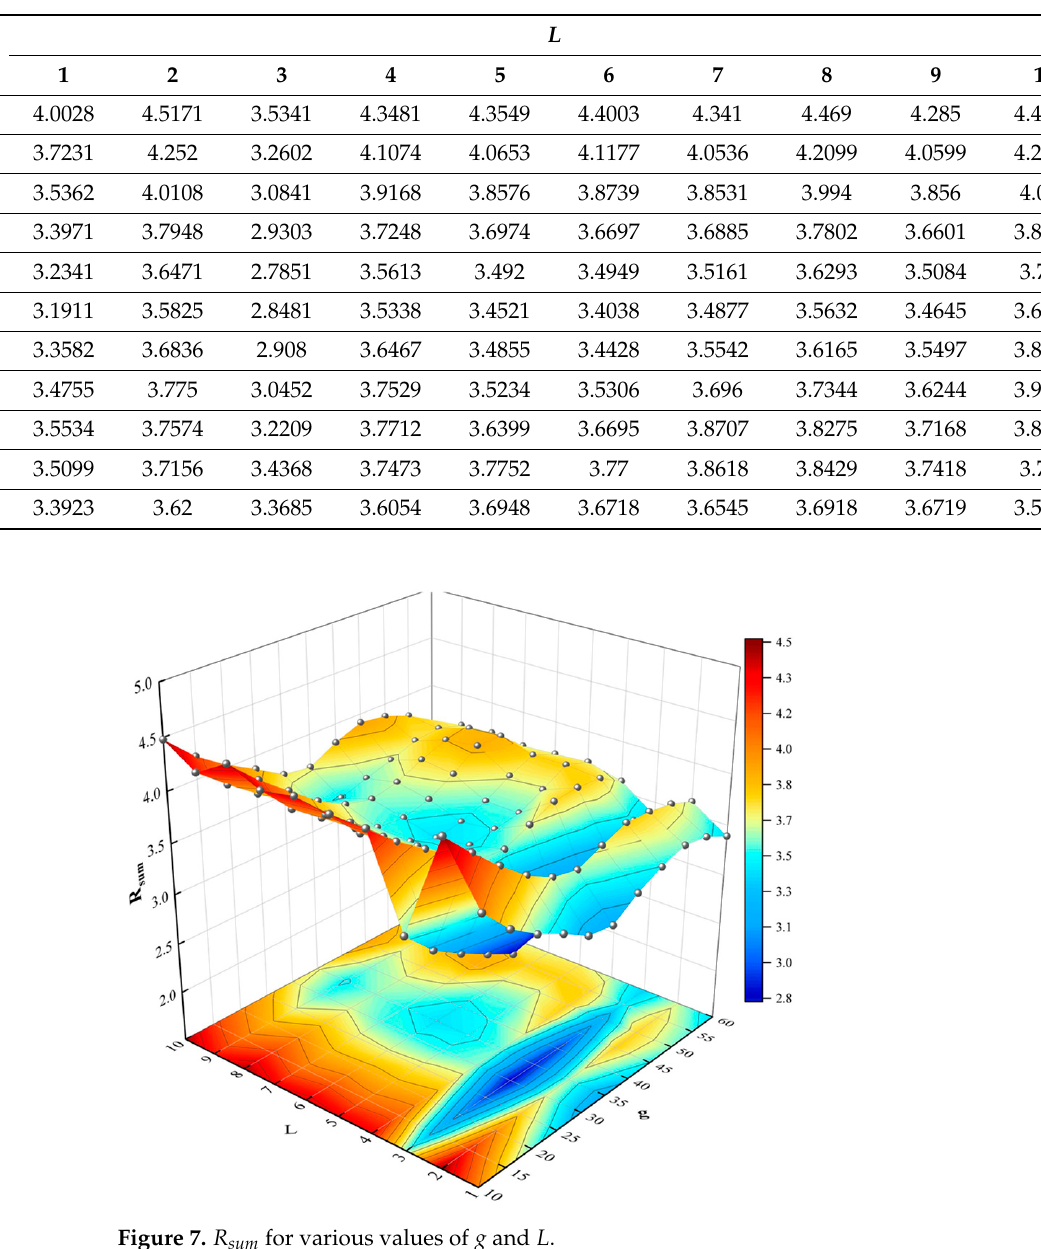
parameter selection on the SDP image, some of the images are shown in Figure 8 while combining g and L . It can be concluded that the highest image quality can be obtained when L = 3 and g = 30 ◦ . As L gradually increases, the arms of the SDP image become progressively fuller. As the value of g increases, the angle between the center of mass of the SDP image arm and the horizontal axis becomes progressively larger. Therefore, the SDP parameters were chosen as θ = 60 ◦ , L = 3, and g = 30 ◦ , respectively. Table 4. R sum for various values of g and L .